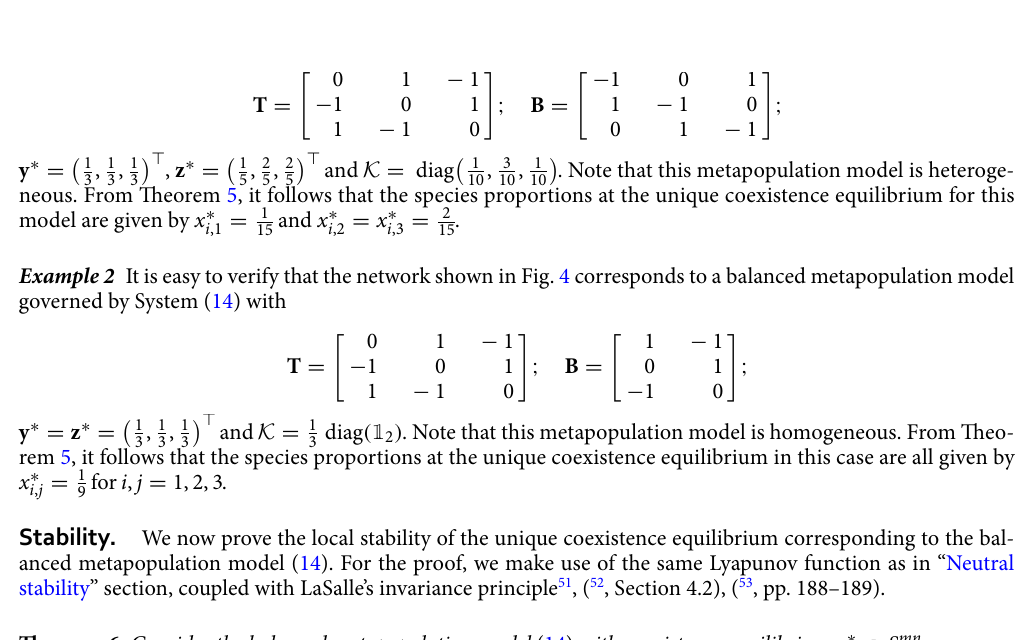
Figure 4. A metapopulation network composed of three patches. Species can migrate from patch 1 to the other two patches and vice versa. However, there exists no migrations between patches 2 and